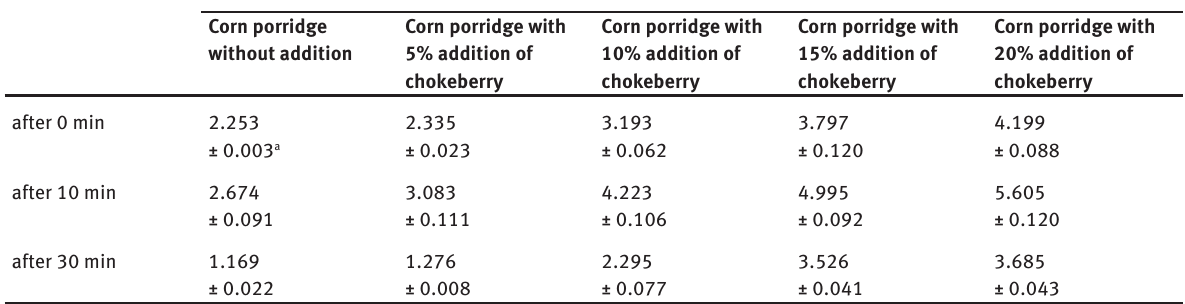
Table 3: Results of TLC-DPPH assay showing the antiradical activity of analysed extracts in relation to the activity of 0.1 mg/mL quercetin solution (activity of quercetin solution equal to “1”).